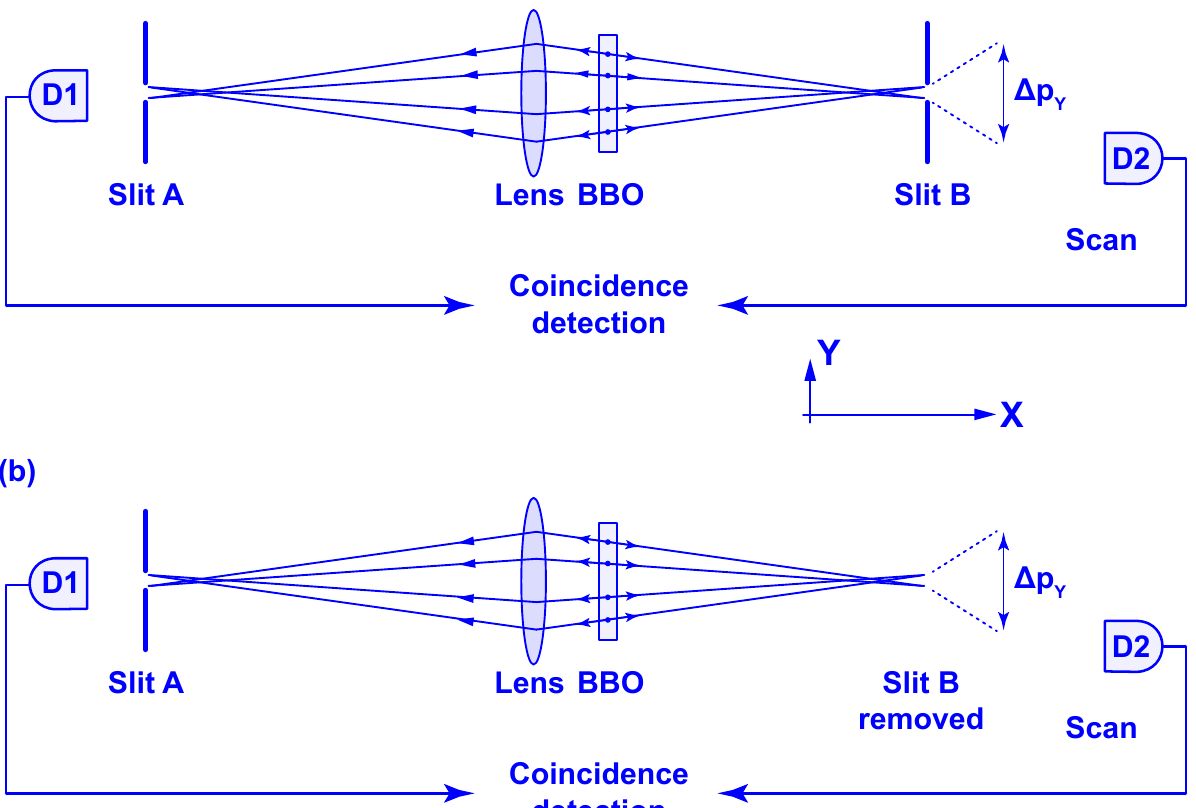
Figure 2: Setup of the photon experiment by Kim and Shih aimed at realizing Popper’s proposal. An EPR photon pair is generated by spontaneous parametric down-conversion in a barium borate (BBO) crystal. A lens (with a focal length f) and a narrow slit A (located at a distance 2 f from the lens) are placed in the path of photon 1 to provide the precise knowledge of its position on the y -axis and also determine the precise y -position of its twin, photon 2, on screen B due to a ‘ghost image’ e ff ect. Two detectors D 1 and D 2 are used to scan in the y -directions for coincidence counts. (a) Slits A and B are adjusted both very narrowly. (b) Slit A is kept very narrow and slit B is